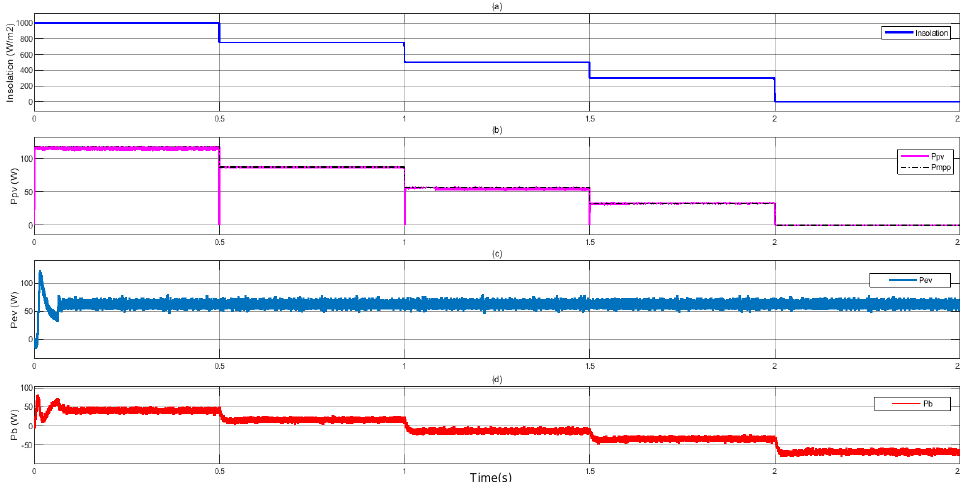
Figure 9. The system response with the PI controller: ( a ) the sun insolation level, ( b ) the PV power, ( c ) the EV battery power, and ( d ) the ESS battery power.